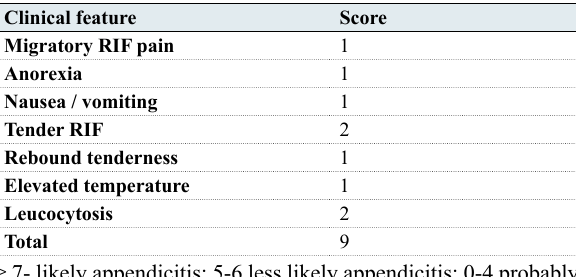
Table 3: Histopathological diagnosis among study